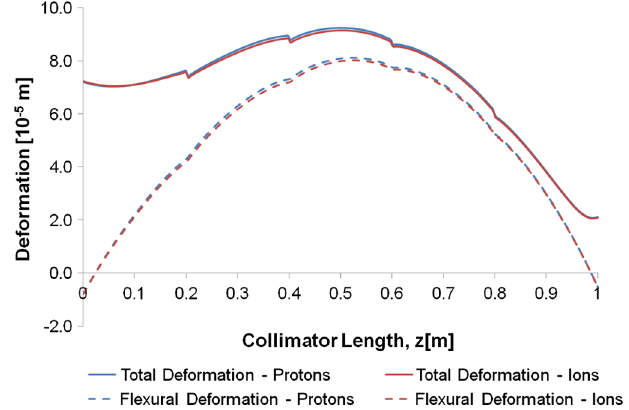
FIG. 20. Comparison of the total and flexural deformations of the collimator jaw assembly for the proton (1 bunch with 4 . 48 × 10 9 protons) and ion (1 nominal ion bunch) beam impacts. The deformations are plotted along Path CD shown in Fig.